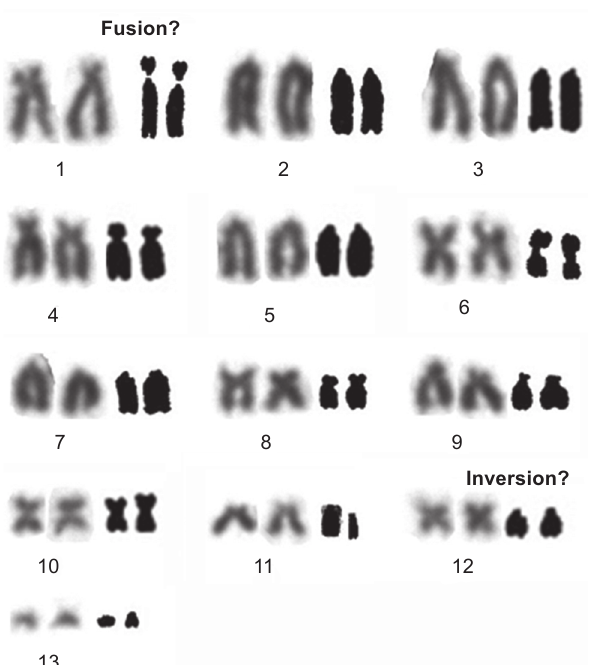
Figure 13. Chromosomal comparison between T. bidens collected in the Brazilian state of Mato Grosso (left) and L. schulzi (H ONEYCUTT et al.